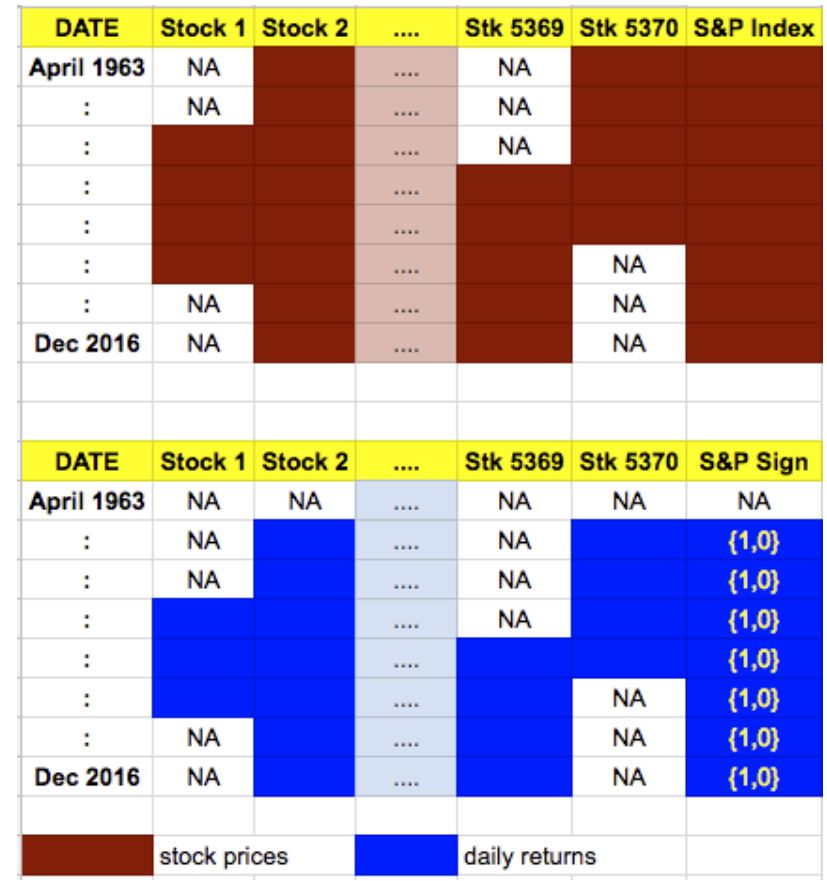
Figure 2. Depiction of the source data, prices and returns. The top panel shows the sparse data on prices and the lower panel shows the data converted to returns, using the formula: R t = ( S t − S t − 1 ) / S t , where R , S stand for returns and stock prices, respectively. One row of data is lost when converting prices to returns. Note that for the index, we convert the data into sign of movement, where the value is 1 if the index moved up, else it is 0. The “NA” values show days for which there is no data